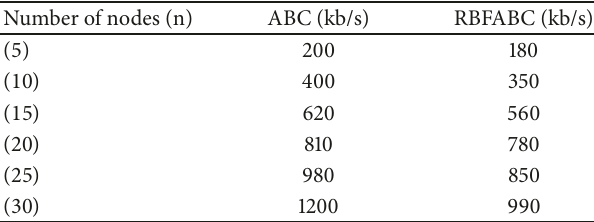
Table 3: Comparison of multimedia data transfer